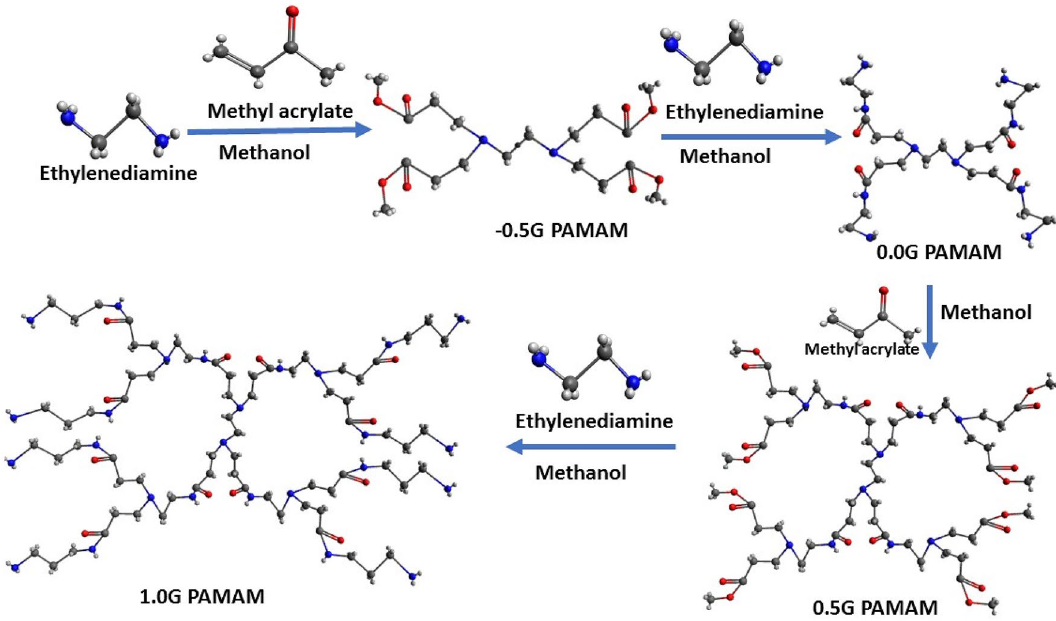
Figure 8. 3D Molecular model illustrating the synthesis of PAMAM dendrimer (Blue: Nitrogen; Grey: Carbon; Red: Oxygen) (Avogadro 1.1.1, http://avoga